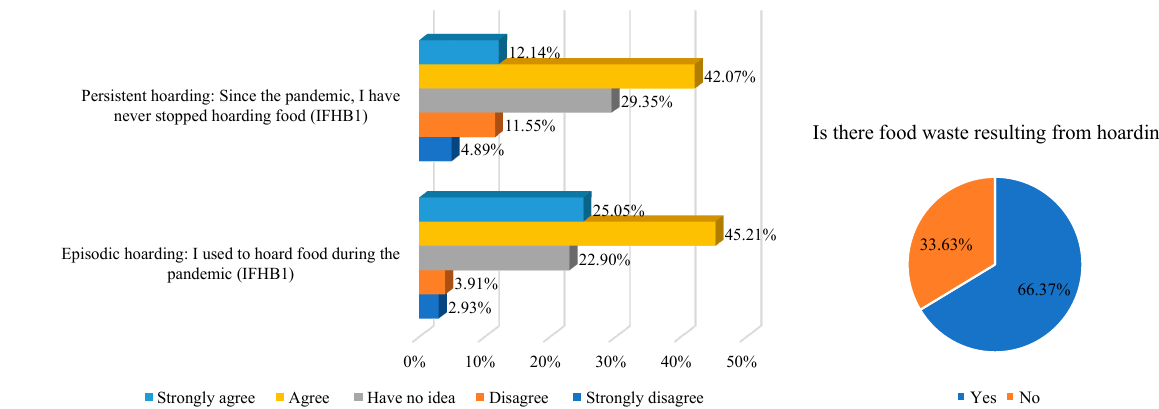
Figure 3. Citizens’ food hoarding behavior and food waste resulting from hoarding. Note: both episodic and persistent hoarding is considered to be food hoarding behavior.